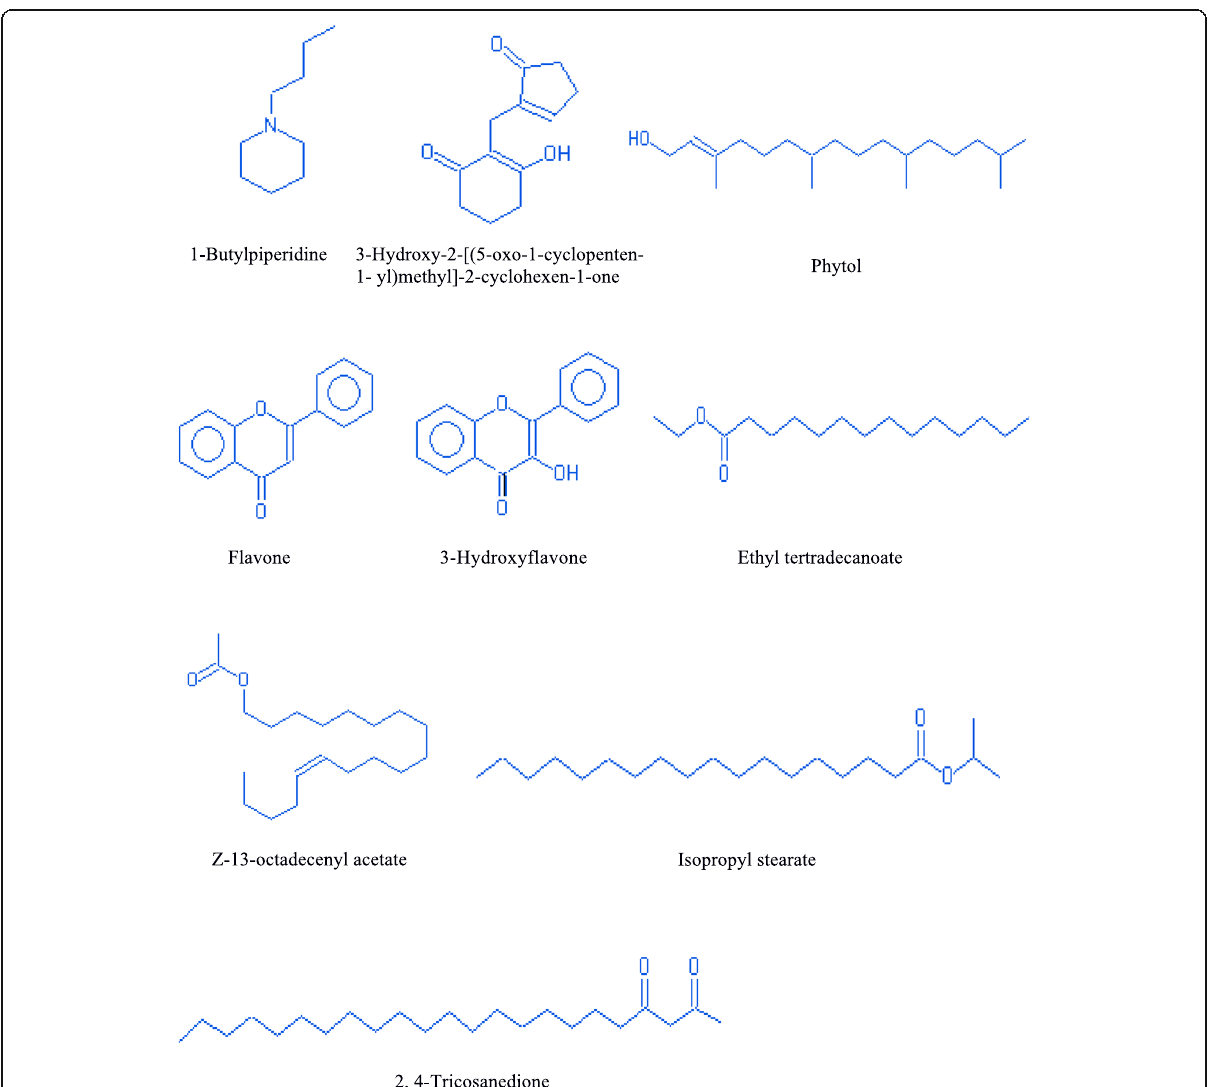
Fig. 7 Structures of phytochemicals detected in the methanolic extract of an in vitro grown L.